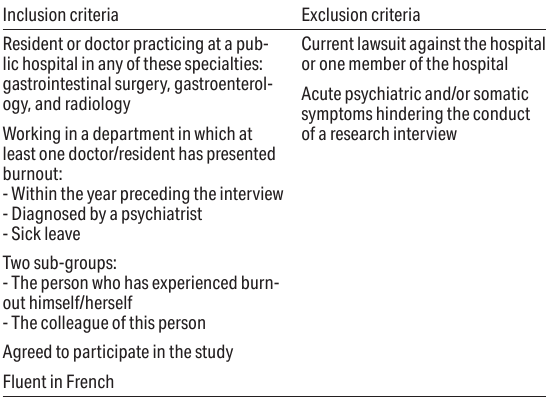
Table 1. Inclusion and exclusion criteria. Inclusion criteria Exclusion